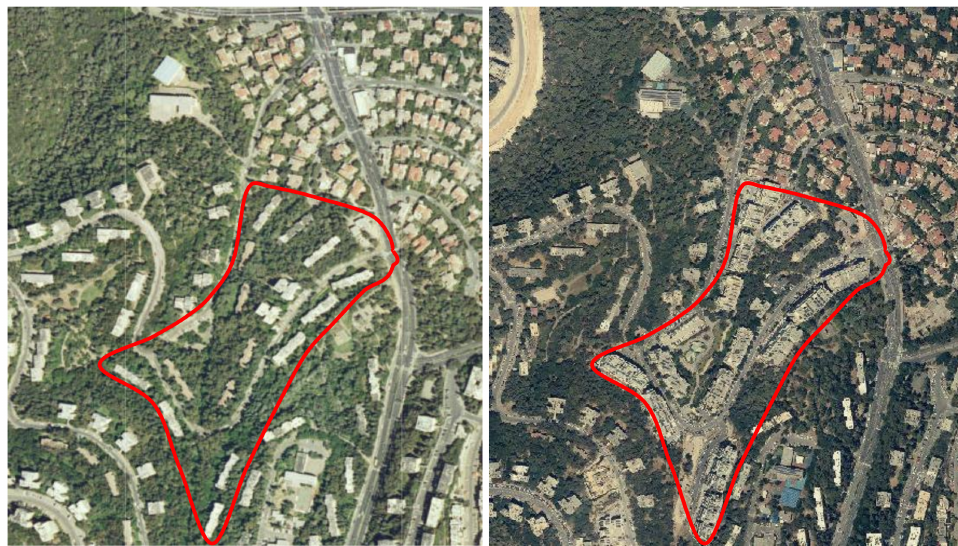
Figure 9. Increased land cover and lack of green areas. From the https://www.govmap.gov.il/ website, accessed on 7 May 2022 and drawing by the authors, 2022. Source: the Israeli “govmap” website archive.